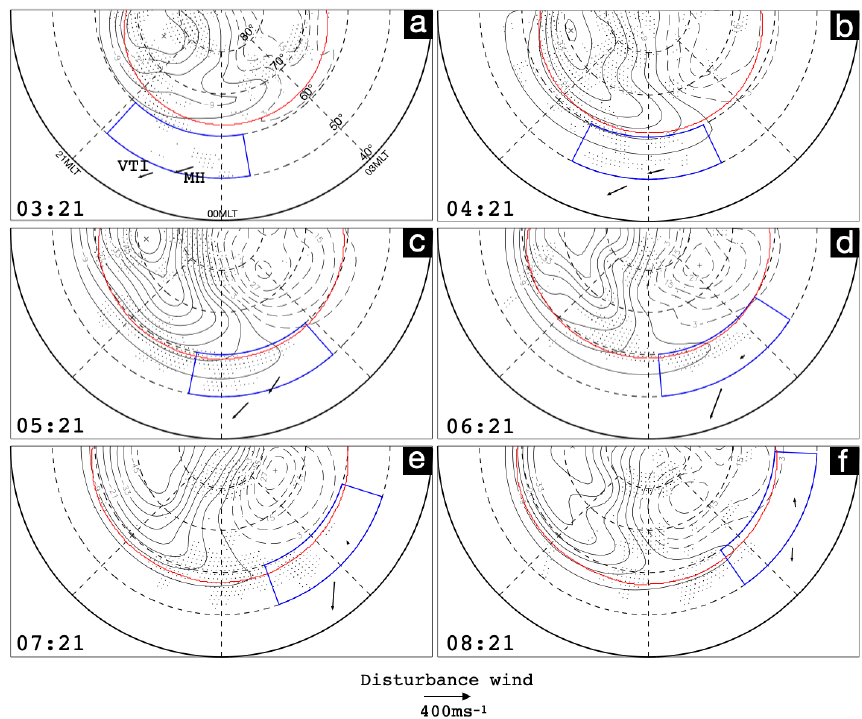
Figure 5. Polar plots in the same format as Fig. 4, except with the SuperDARN global fitted electric potential contours (in kV) instead of the radar LOS data. Black dots are the locations of SuperDARN radar LOS data which contributed to the fit. The blue box is the region over which the fitted plasma velocity was averaged for the purpose of cross-correlation, the results of which are shown in Fig.